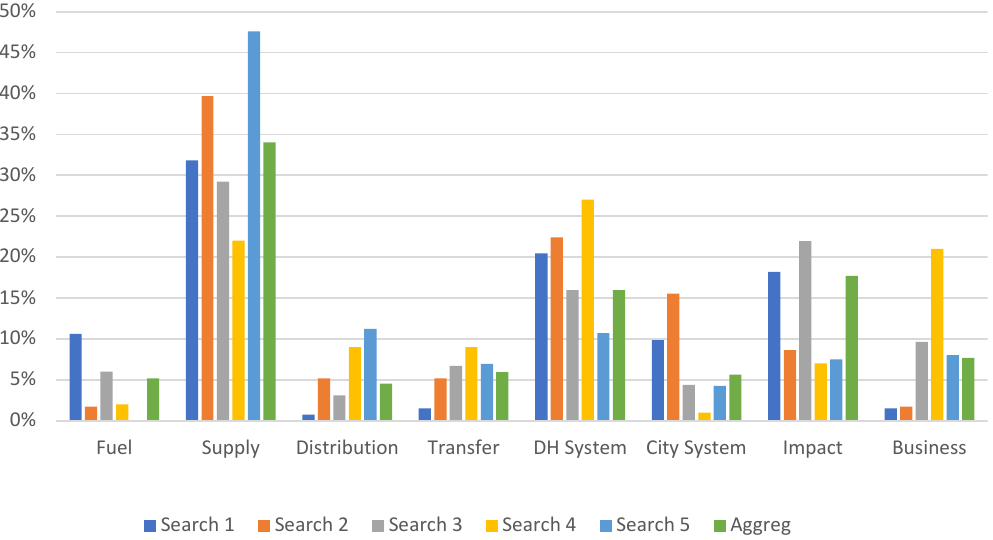
Figure 4. Distribution of articles. A summary of the search and coding in this review (see details in Section 2.2 Data Collection). The 8 groups are listed horizontally. The share, in percentage, of articles per search is shown on the vertical axis. The aggregated share from all five searches is also shown.